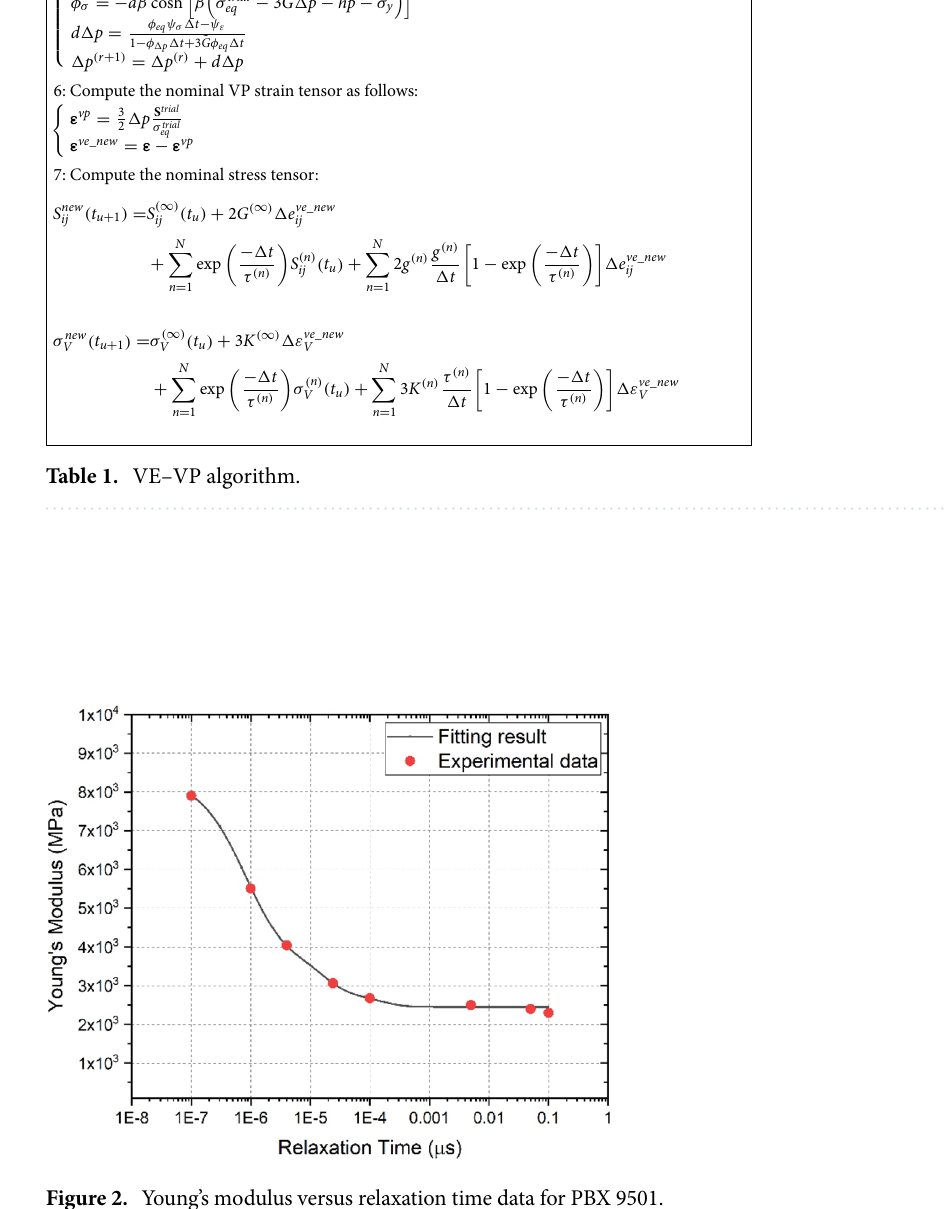
Figure 2. Young’s modulus versus relaxation time data for PBX